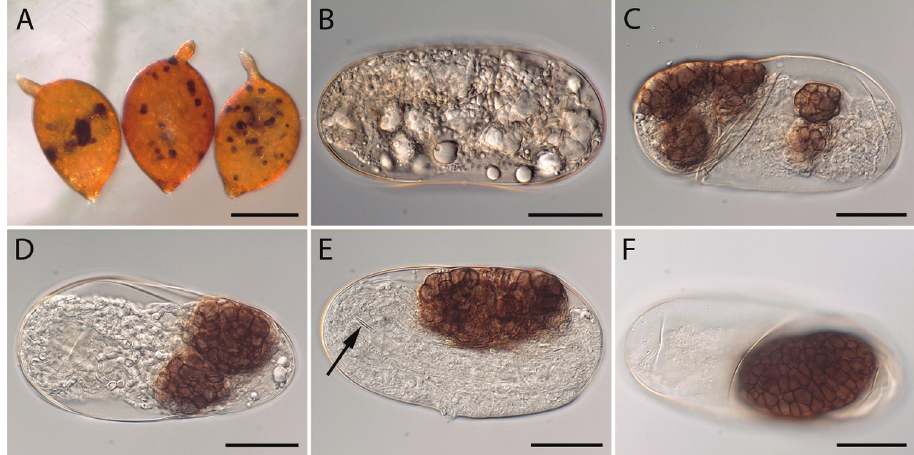
Figure 5. Cysts and eggs of Heterodera filipjevi infected by Monocillium bulbillosum in vitro. A Sympto- matic cysts infected by M. bulbillosum B Infected egg showing early stage of fungal colonisation C–F For- mation of microsclerotia in nematode eggs (arrow points at nematode’s stylet). Scale bars: 300 µm ( A ); 30 µm ( B–F